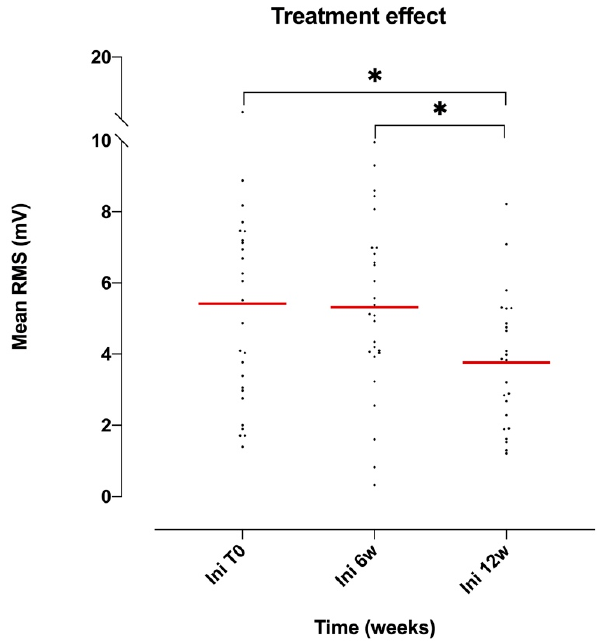
Figure 3. Scatter dot plot around the mean mRMS value of the AM muscle at the first 3 min of the session (Ini) in relation to the treatment time (T0: first session, 6 w: week 6, 12 w: week 12). Tukey multiple-comparison test: * ( p < 0.05).